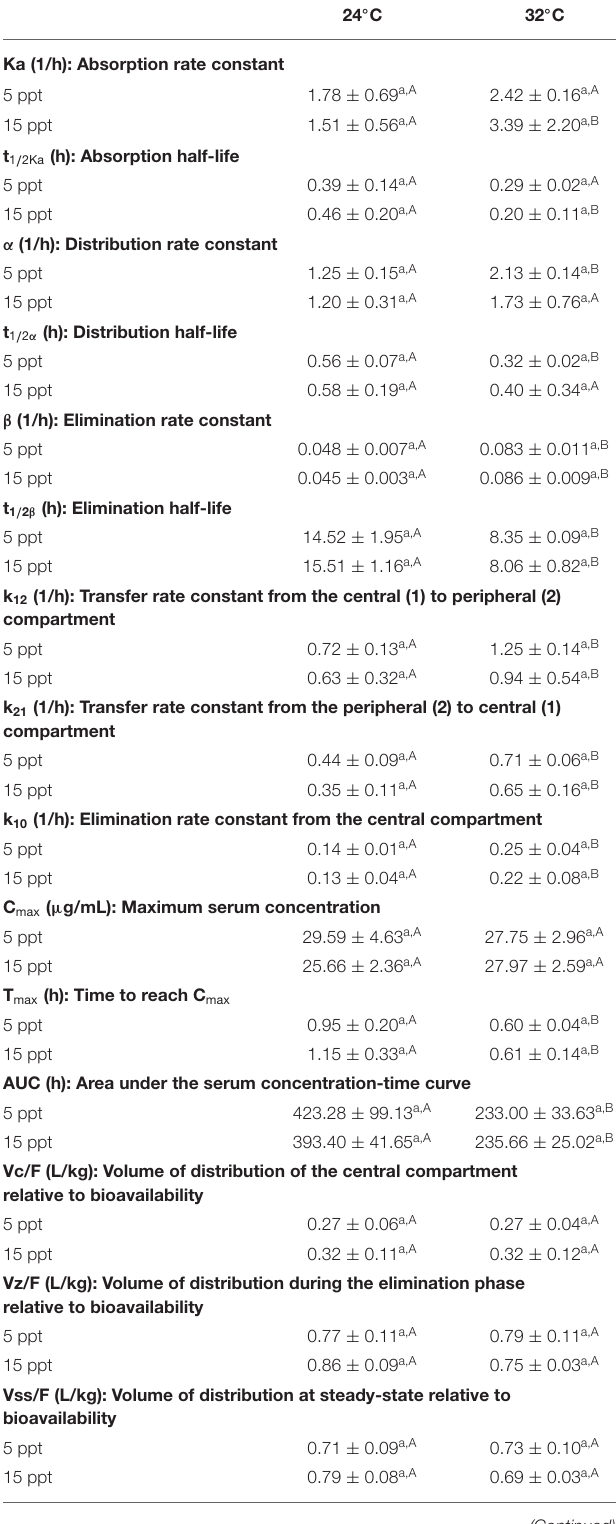
TABLE 1 | Pharmacokinetic parameters (mean ± SD) of florfenicol following oral administration (15 mg/kg) at two temperatures and two salinities ( n = 4 for the 32 ◦ C with 15 ppt group; n = 7 for the other three groups).